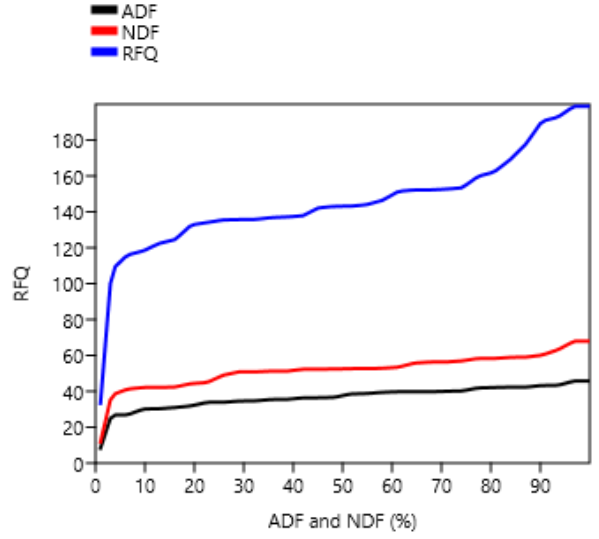
Figure 6. Relationship between detergent fibres and relative feed